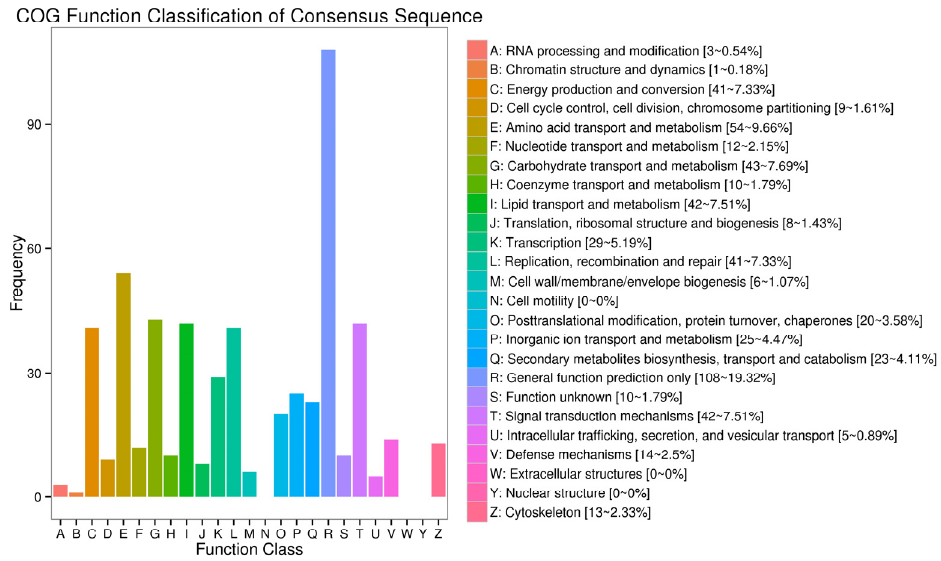
Figure 3. Gene ontology (GO) categorization of DEGs in the treatment and control groups of uni- genes.